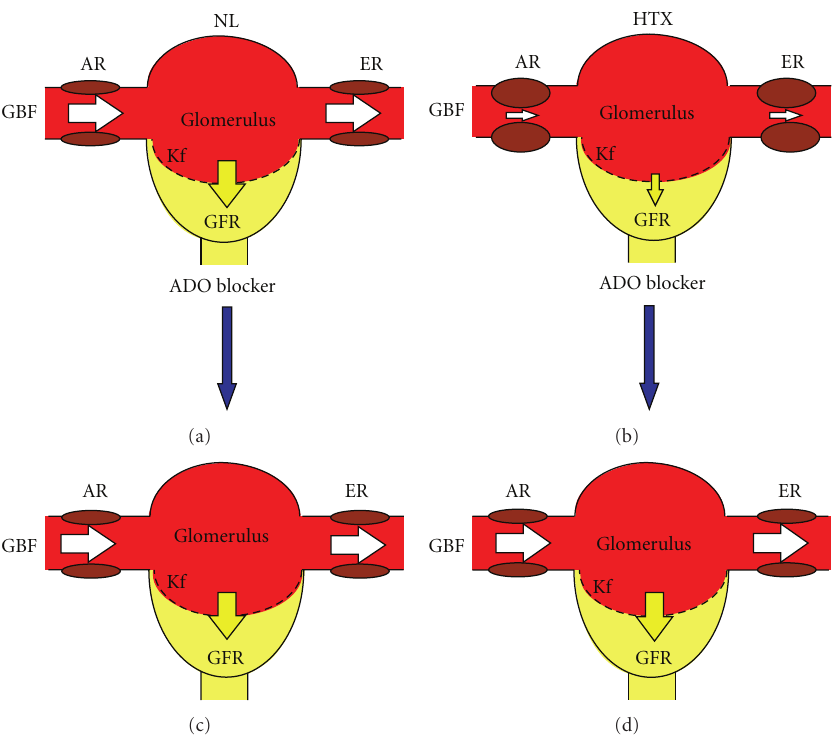
Figure 4: Response to an adenosine (ADO) blocker (PSPX) in glomerular hemodynamics from normal (NL) and hypothyroid (HTX) rats. (a) The balance of glomerular blood flow (GBF), the a ff erent and e ff erent resistances (AR, ER, resp.), and the permeability of the glomerular capillary membrane (Kf) maintain a normal glomerular filtration rate (GFR). (c) Since normal glomerular hemodynamics is not importantly regulated by adenosine, the administration of an adenosine blocker does not modify the GFR. (b) In contrast, renal vasoconstrictions are observed under hypothyroid conditions. (d) The administration of an adenosine blocker completely reverses the alterations of glomerular hemodynamics in the hypothyroid kidney. White arrows are indicative of magnitude of AR or ER, whereas yellow arrows represent the magnitude of the glomerular filtration